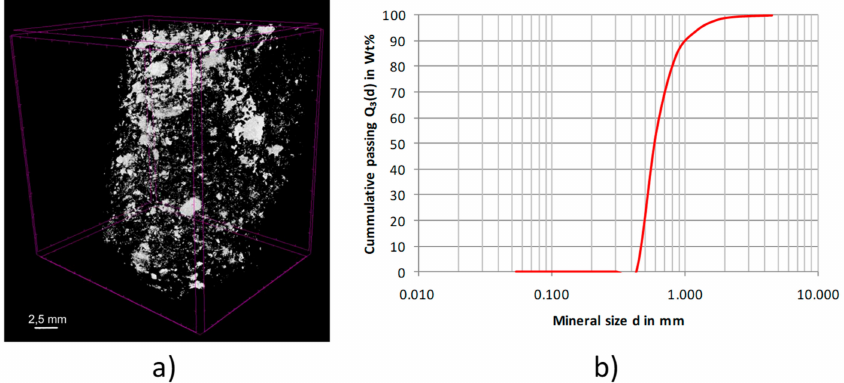
Figure 11. ( a ) Mica in the volume of granodiorite and ( b ) their distribution according to the maximum diameter.